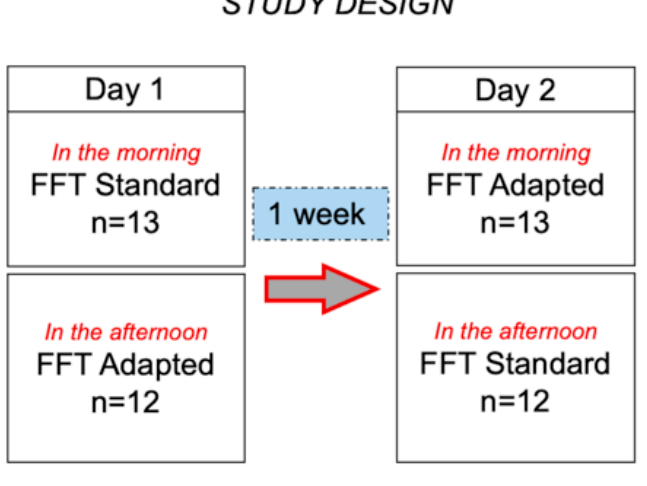
Figure 1. Study Figure 1. Study design.